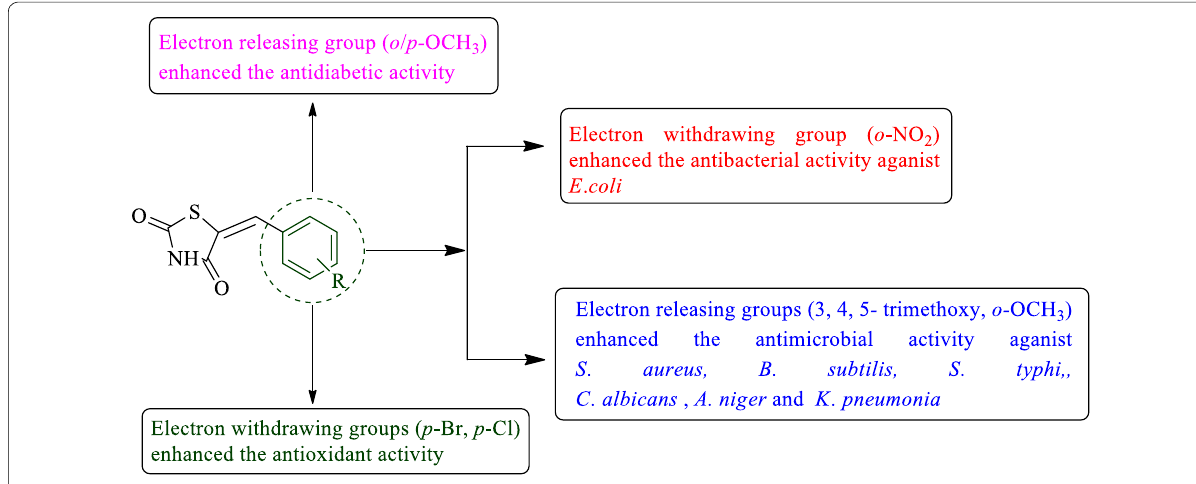
Fig. 8 Structural activity relationship studies of synthesized